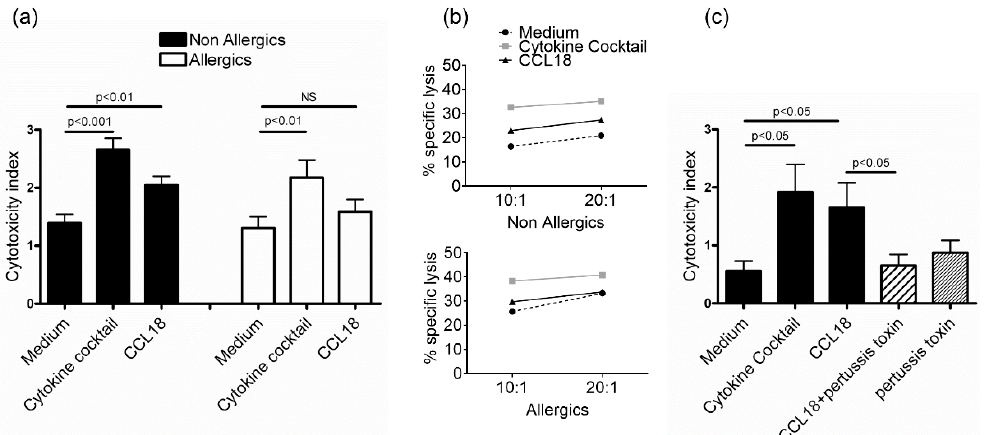
Figure 3. CCL18 enhances cytotoxic activity of NK cells from nonallergic donors in a G-protein-dependent manner.